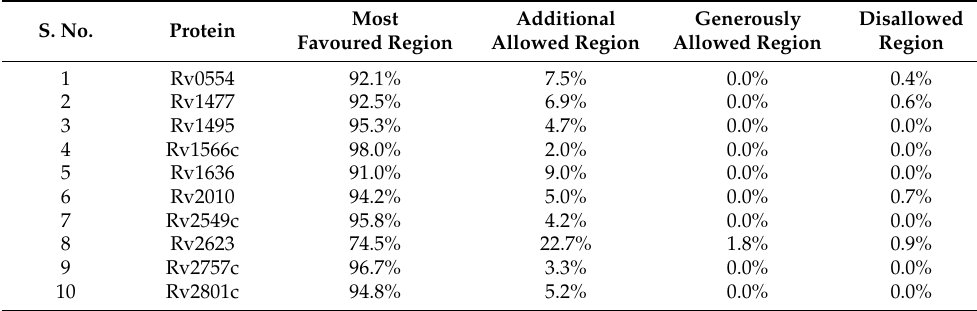
Table 4. Ramachandran plot statistics of selected virulent category